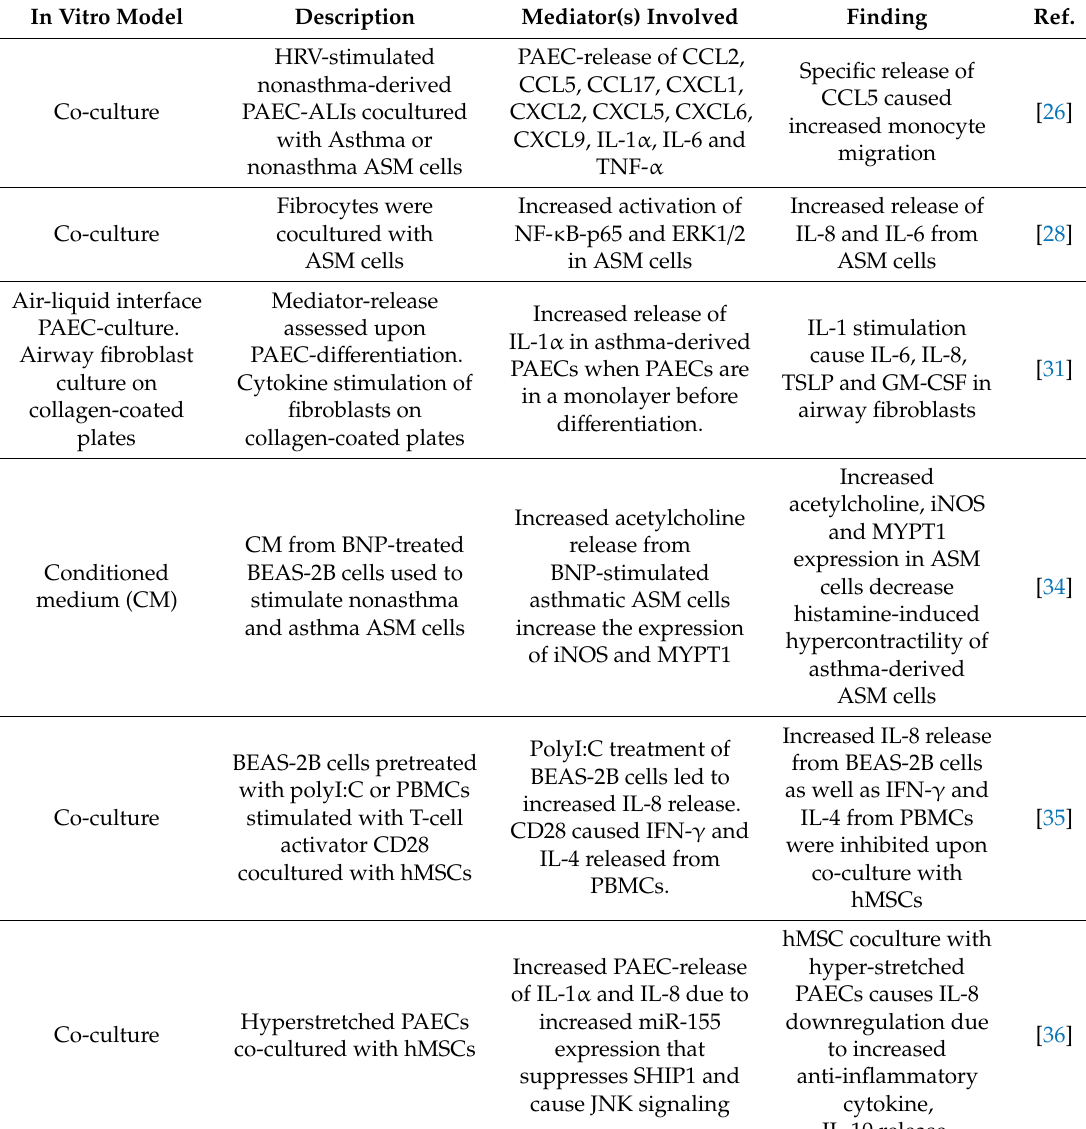
Table 1. Summary of studies assessing airway inflammation in asthma with epithelial-mesenchymal trophic unit (EMTU)